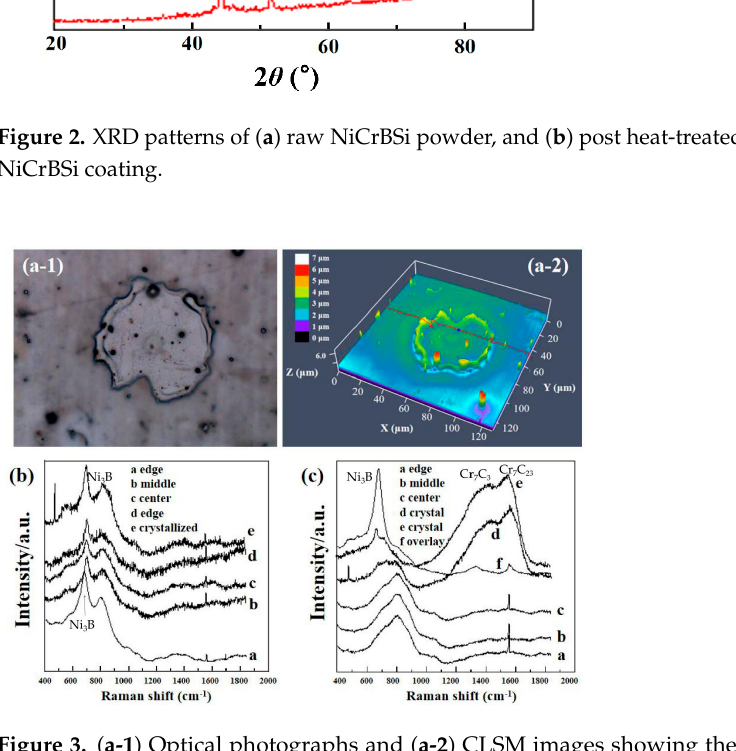
Figure 3. ( a-1 ) Optical photographs and ( a-2 ) CLSM images showing the surfaces of a deposited flat NiCrBSi particle, and phase composition of ( b ) a deposited flat NiCrBSi particle and ( c ) after corrosion process.